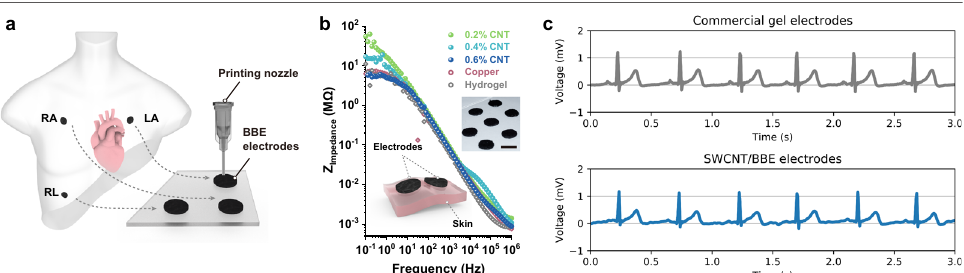
Fig.5|3D-printedSWCNT/BBEelectrodesforECGrecording.a Schematicofthe ECG measurement. RA, LA, and RL represent the locations of right arm electrodes, leftarmelectrodes,andrightlegelectrodes,respectively.ThethreeECGelectrodes were3Dprintedwith0.6wt%SWCNT/BBE.Dimensionsarenottoscale. b Bodeplot of skin impedance measurements using SWCNT/BBE, copper sheet, and hydrogels